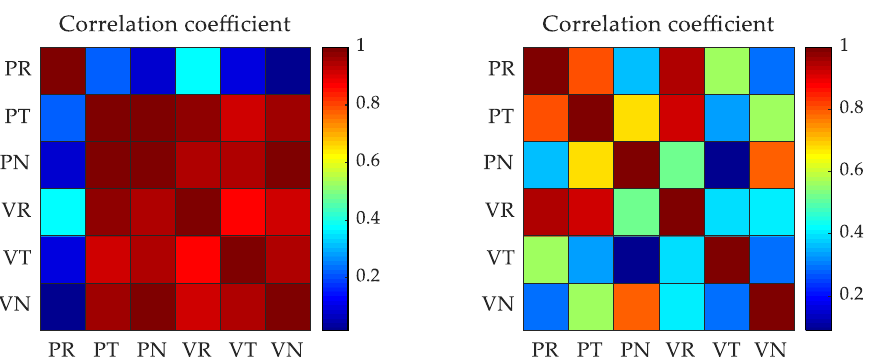
Figure 5. The correlation coefficient of the initial spacecraft states computed with different data (Left: Doppler data, Right: Doppler and image data). “R”, “T”, and “N” denote radial, tangential, and normal directions, respectively. (P: position, V: velocity).